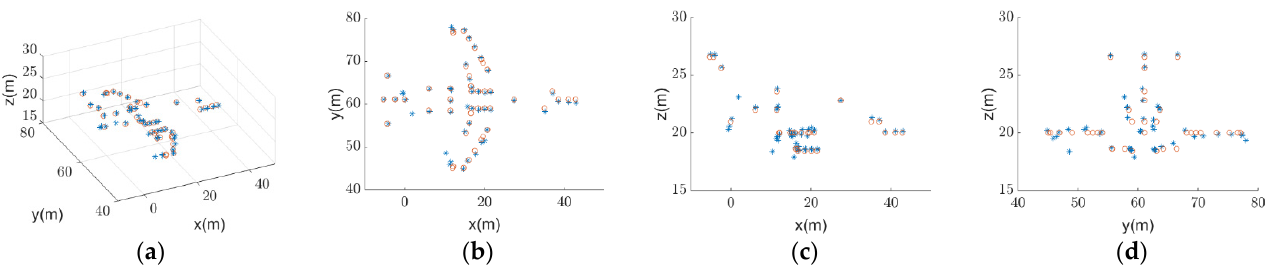
Figure 9. 3D imaging results obtained by the proposed method with the Q scatterer at position (9.980, 9.939, 9.980) km taken as the reference scatterer in ( a ) 3D; ( b ) projection on x-y plane; ( c ) projection on x-z plane; ( d ) projection on y-z plane.